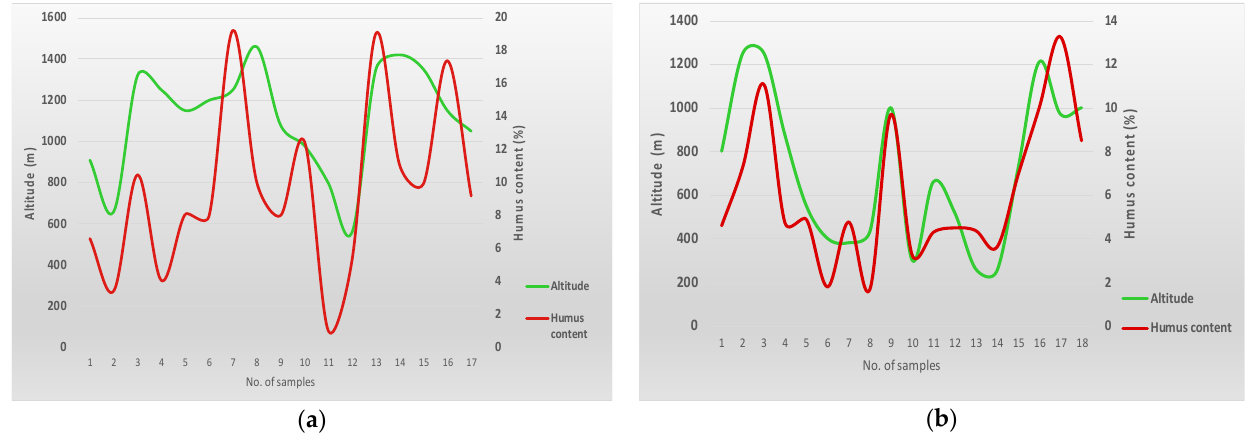
Figure 6. Correlation between soil organic matter content and altitude (( a )—dystric cambisol; ( b )—eutric cambisol).